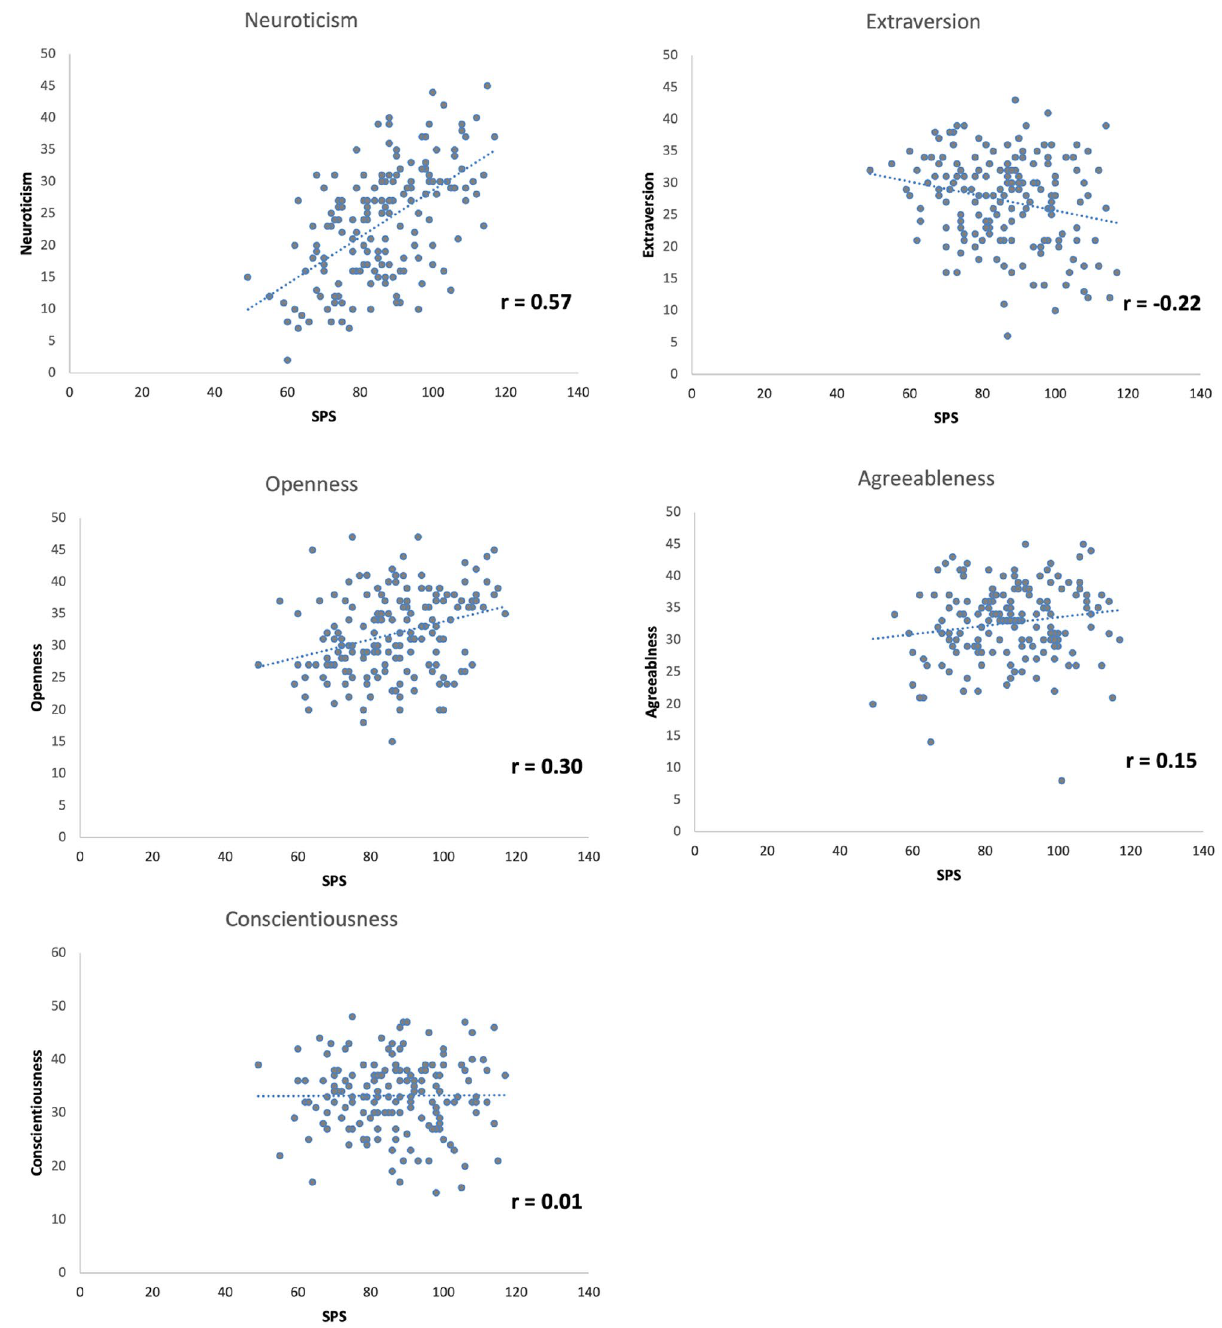
Figure 1. Scatterplots of SPS and Big Five personality measures (NEO-FFI). Results demonstrate significant positive correlations of neuroticism and openness with SPS. Extraversion was negatively related to SPS (Pearson